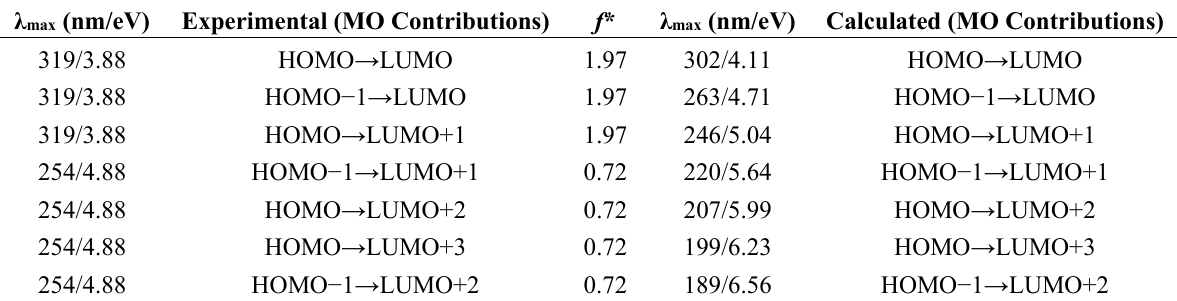
Table 6. Experimental and calculated energy of molecular orbitals of (II) and associated transitions.